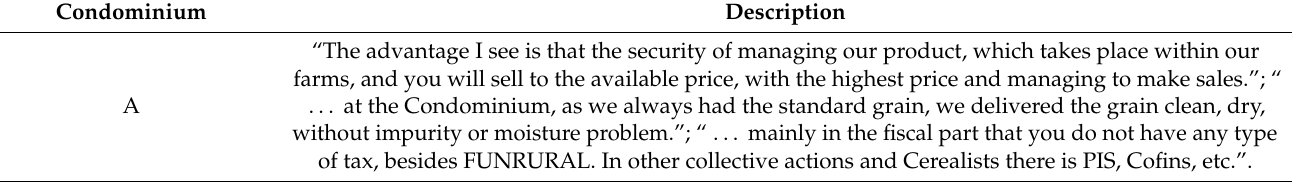
Table 2. Interviewees’ statements about the advantages of the collective rural model of Condomini- ums of Rural Warehouses compared to other